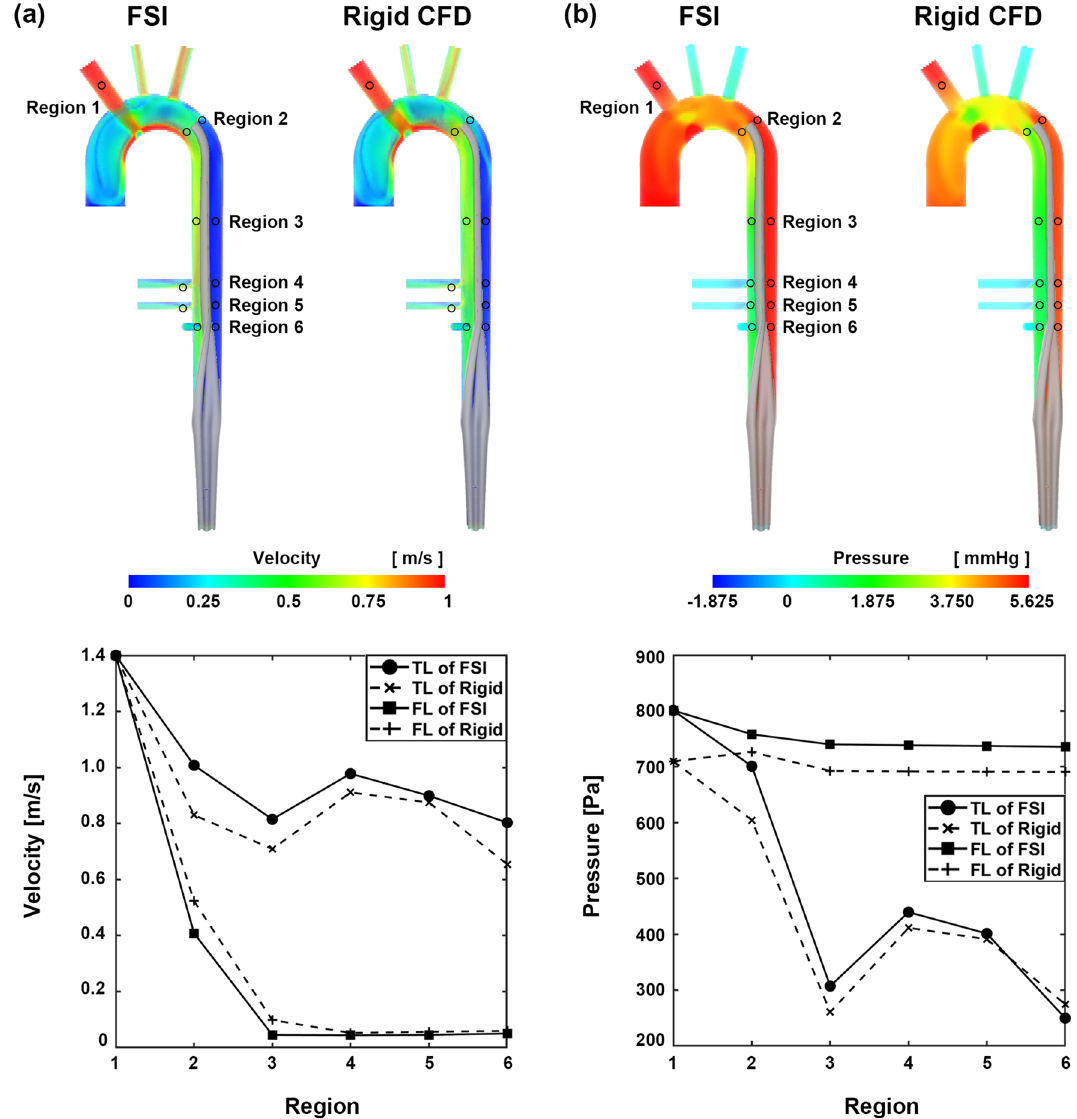
Figure 7. Velocity and pressure contour comparison of rigid CFD and FSI at an AC flow rate of 7 L/min. ( a ) Velocity and ( b ) pressure. The graphs show the maximum velocity and pressure in each region. These images were made from Ensight (v.2021 R1, https:// www. ansys. com) using FSI data.